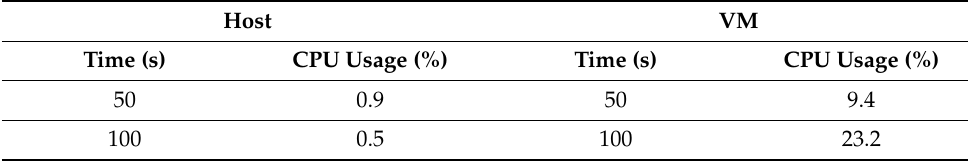
Figure 4. CPU utilization. Table 2. CPU utilization values based on CPU usage and time. Table 2. CPU utilization values based on CPU usage and time.